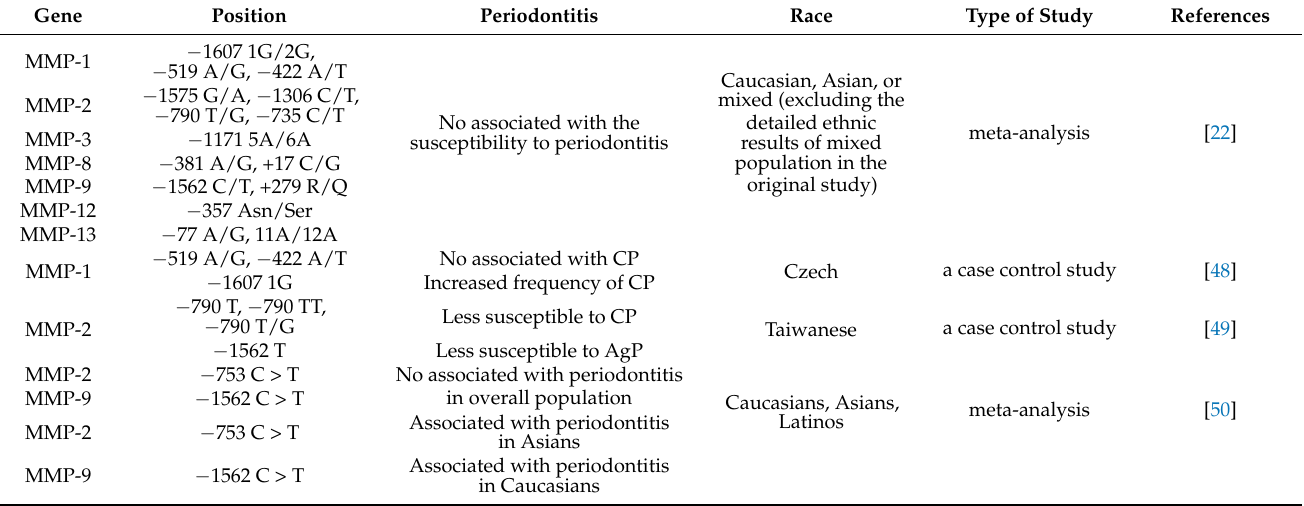
Table 2. Matrix metalloproteinases (MMPs) gene polymorphisms related to chronic and aggressive